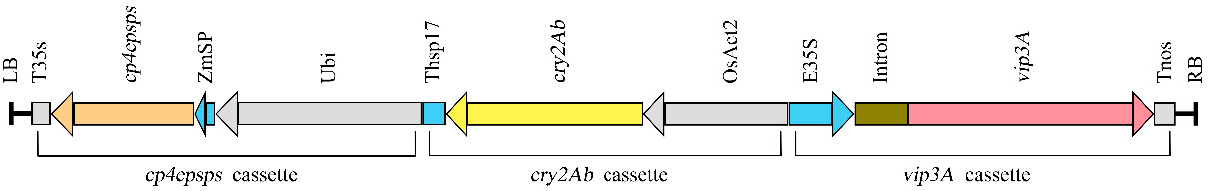
Figure 1. A schematic diagram of the T-DNA region harboring cry2Ab , vip3A and cp4epsps expres- sion cassettes.LB: left border of T-DNA; T35s: CaMV35S terminator; cp4epsps : cp4epsps gene; ZmSP: maize EPSPS signal peptide; Ubi: maize ubiquitin promoter; Thsp17: heat shock protein Hsp17 terminator; cry2Ab : Bt insecticidal cry2Ab gene; OsAct2: rice Actin2 promoter; E35S: enhanced CaMV35S promoter; Intron: first intron of the rice Actin gene; vip3A : Bt vip3A gene; Tnos: nos terminator; RB: right border of T-DNA.